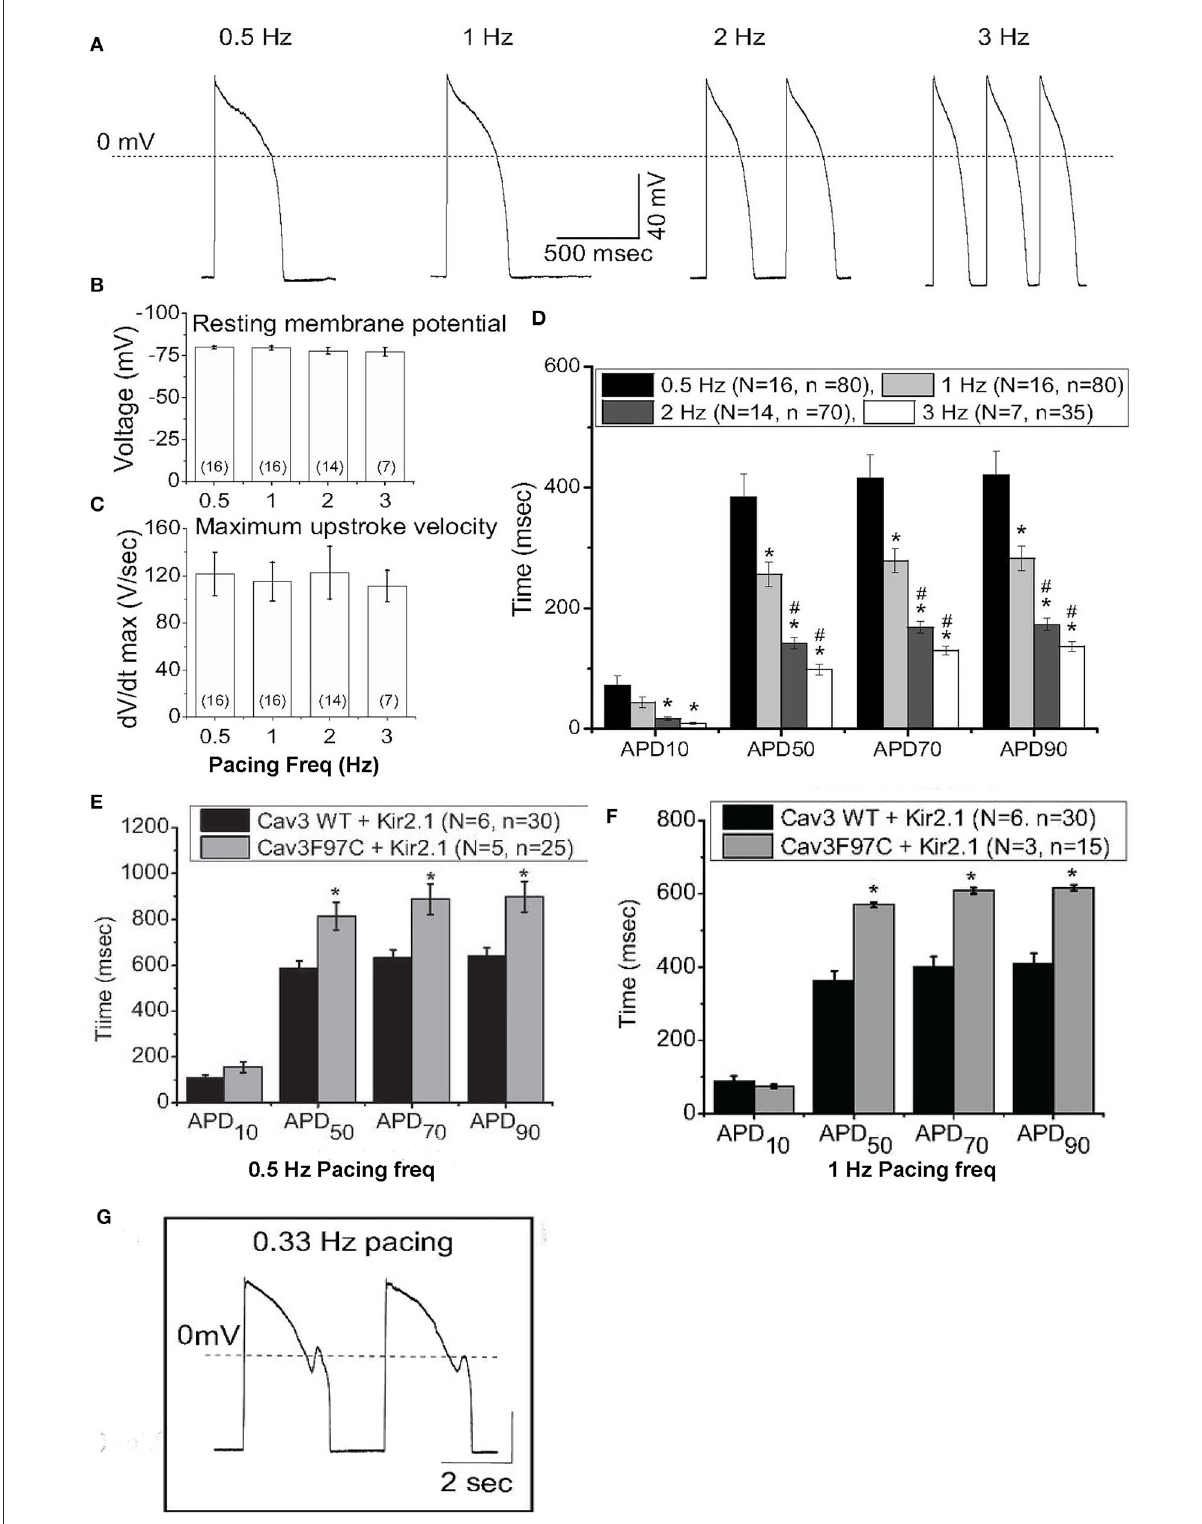
FIGURE1 IK1 enhancement of iPS-CMs results in improved action potential (AP) characteristics. (A) Representative AP from IK1-enhanced iPS-CMs, paced at 0.5-3Hz at physiological temperature. (B) Resting membrane potential from IK1-enhanced iPS-CMs at different pacing frequencies. (C) dV/dTmax of iPS-CMs at different pacing frequencies. (D) Action potential duration (APD) at 10% (APD10), 50% (APD50), 70% (APD70) and 90% (APD90) at pacing frequencies 0.5Hz (black), 1Hz (dark grey), 2Hz (light grey), and 3Hz (white). (E) APD at APD10, APD50, APD70 and APD90 at 0.5Hz pacing from IK1 -enhanced iPS-CMs infected with WT Cav3 or LQT9-associated Cav3 mutation, F97C. (F) APD from IK1 -enhanced iPS-CMs expressing WT-Cav3 or F97C-Cav3 at 1Hz pacing. (G) Bradycardic pacing induced EADs in IK1-enhanced iPS-CMs expressing F97C-Cav3. Modified from